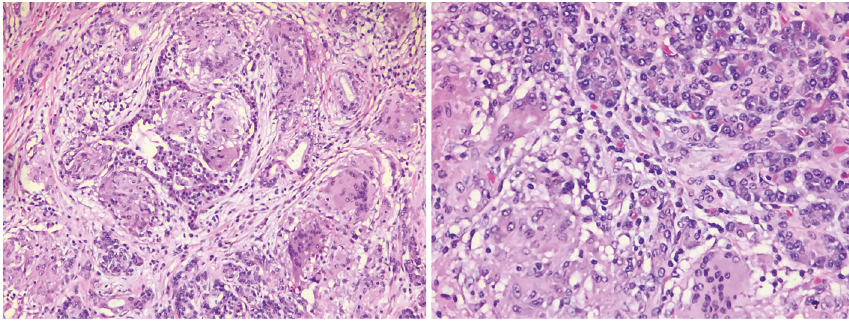
Figure 3: H&E stain of pancreatic mass at intermediate and high